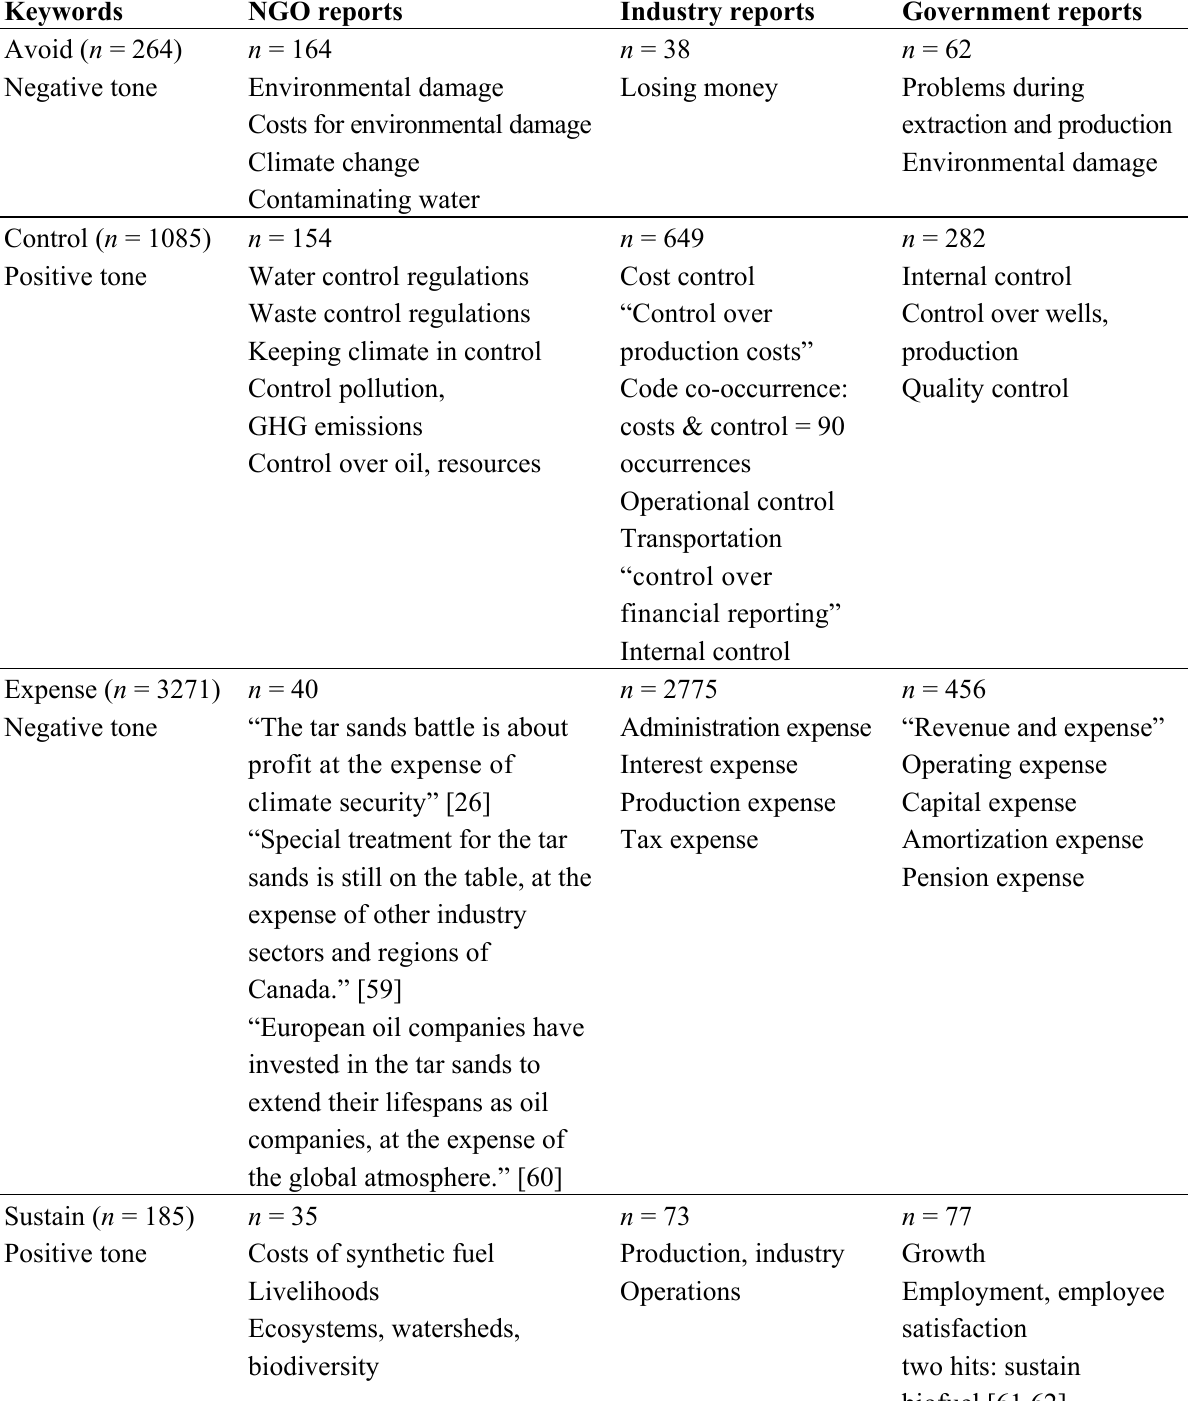
Table 9. Keywords with the same tone used in different